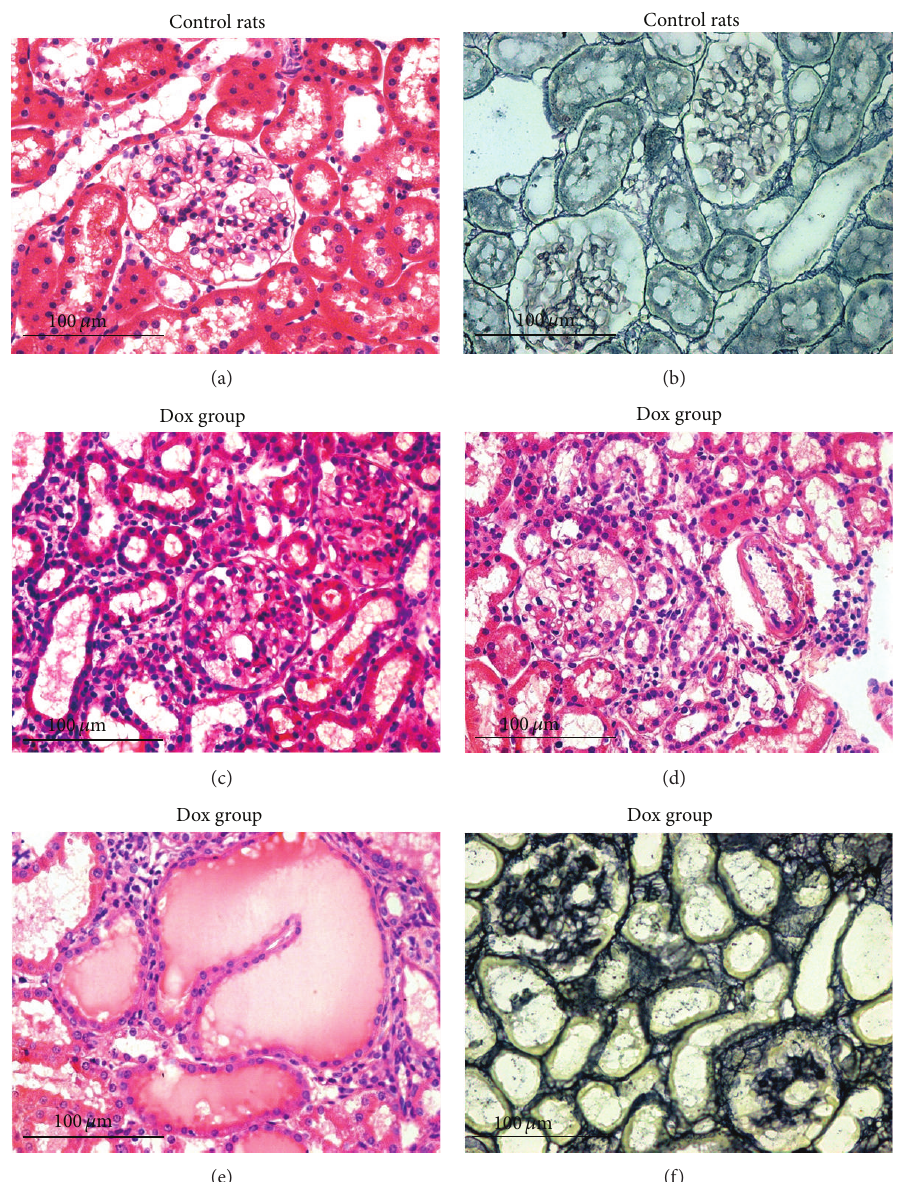
Figure 1: Renal histological changes in rats with doxorubicin-induced nephropathy. Control group ((a) and (b)): normal tissue appearance (HE and Gomori ammonium silver, resp.); Dox group ((c) and (d)) Day 28 after doxorubicin injection: reduction in glomerular cellularity and increased tubulointerstitial cellularity (HE). Dox Group ((e) and (f)) on Day 28: areas of hyaline deposits and interstitial expansion (HE and ammonia Silver, resp.). Focal glomerulosclerosis with partial obliteration of glomerular capillaries in (f) (Gomori ammonium silver). Scale bar 100 𝜇